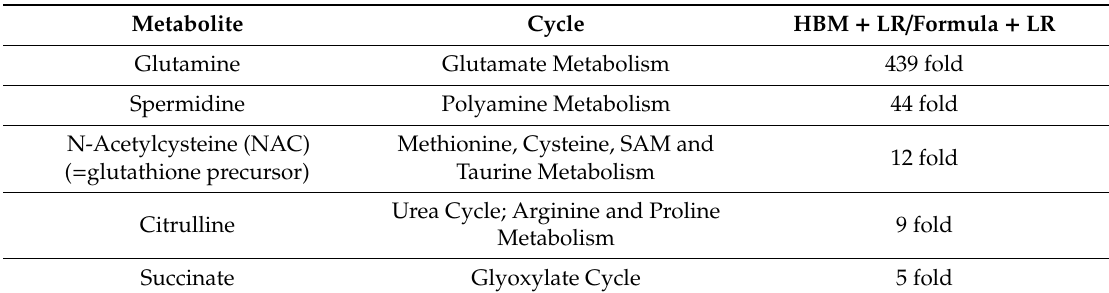
Table 1. Elevated amino acids involved in anti-inflammation function and succinate (part of glyoxylate cycle to generate ATP) in HBM + LR group as compared to formula + LR group.